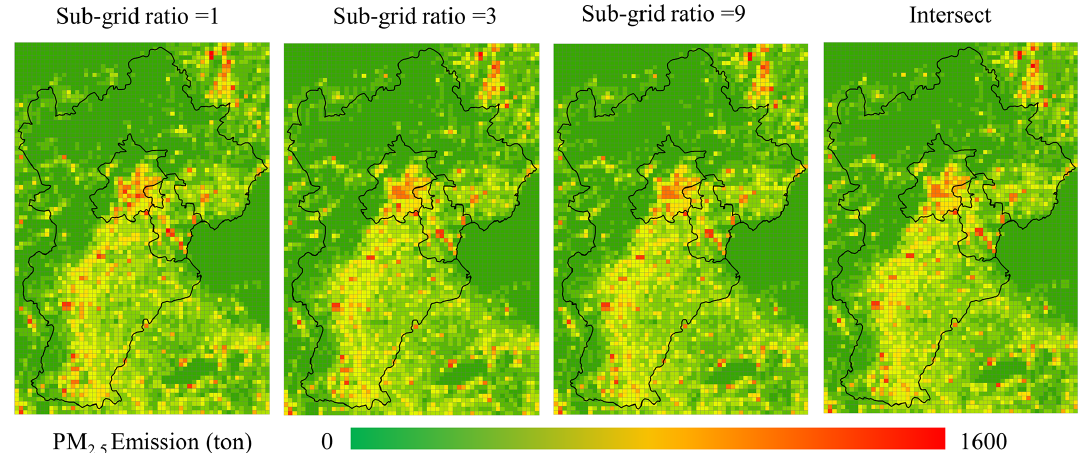
Figure 6. Comparison of the intersect and the sub-grid nearest method allocations with different sub-grid ratios.